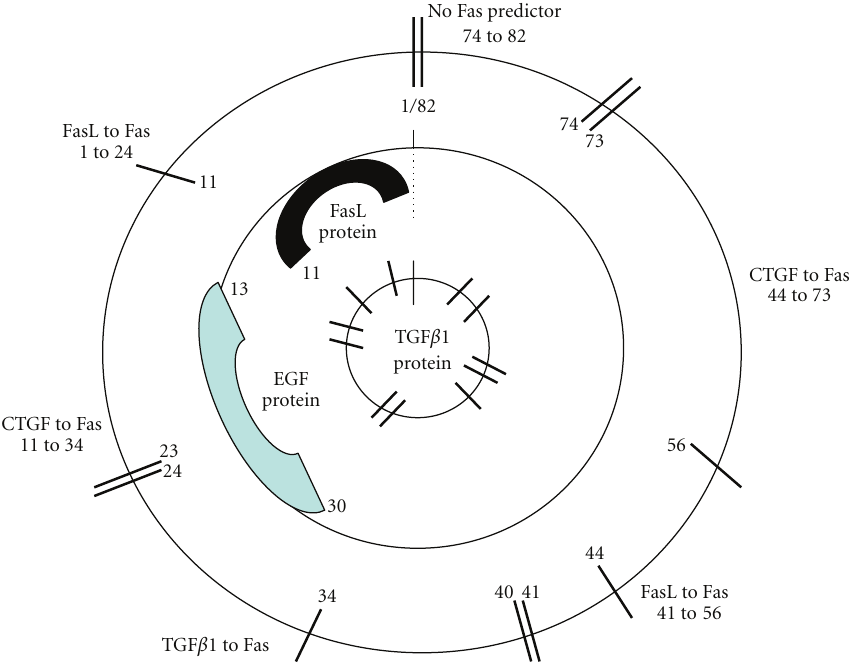
Figure 2: EGF/CTGF/Fas mRNA